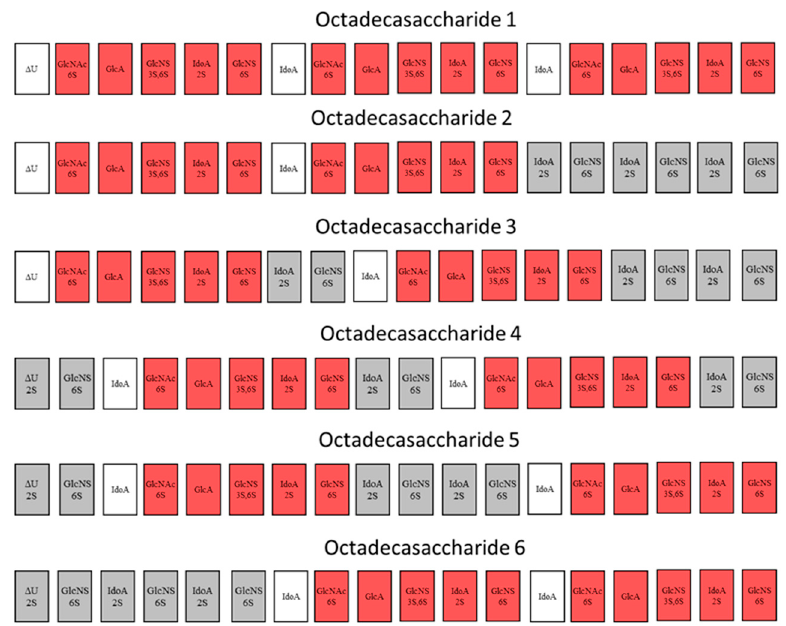
Figure 1. Studied octadecasaccharides (in red saccharide units from AGA*IA sequence). In grey, flanking saccharide units are represented. In white, additional uronic acid present in the minimal natural.